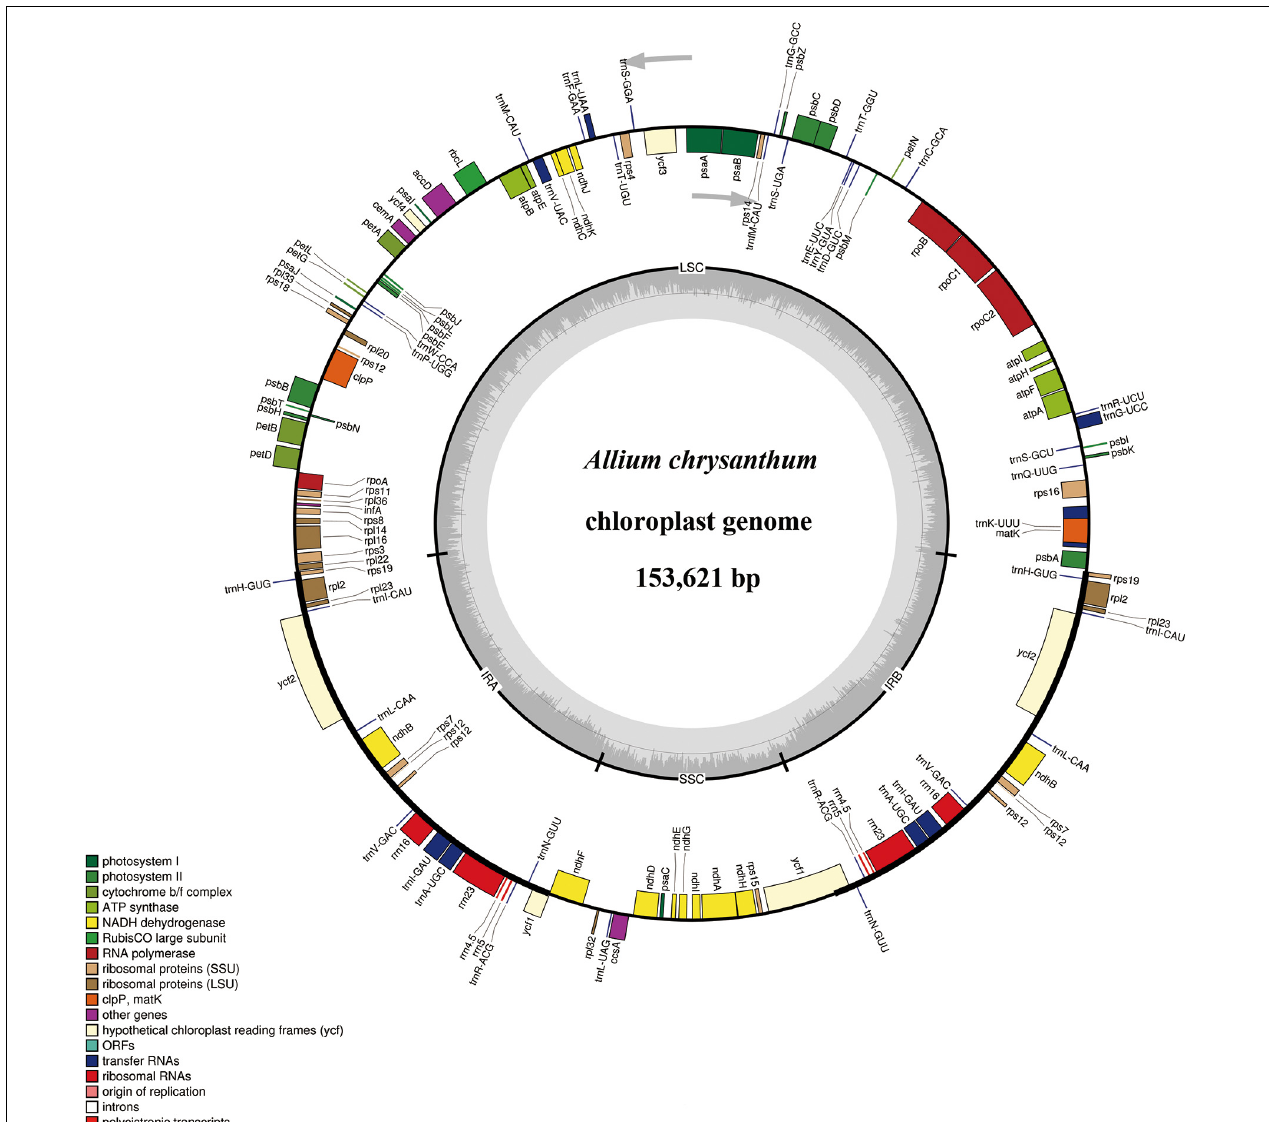
FIGURE 2 | Gene maps of the Section Daghestanica species chloroplast (cp) genomes. Genes shown inside the circle are transcribed clockwise, and those outside are transcribed counterclockwise. Genes belonging to different functional groups are color-coded. The darker gray color in the inner circle corresponds to the GC content, and the lighter gray color corresponds to the AT content. SSU, small subunit; LSU, large subunit; ORF, open reading